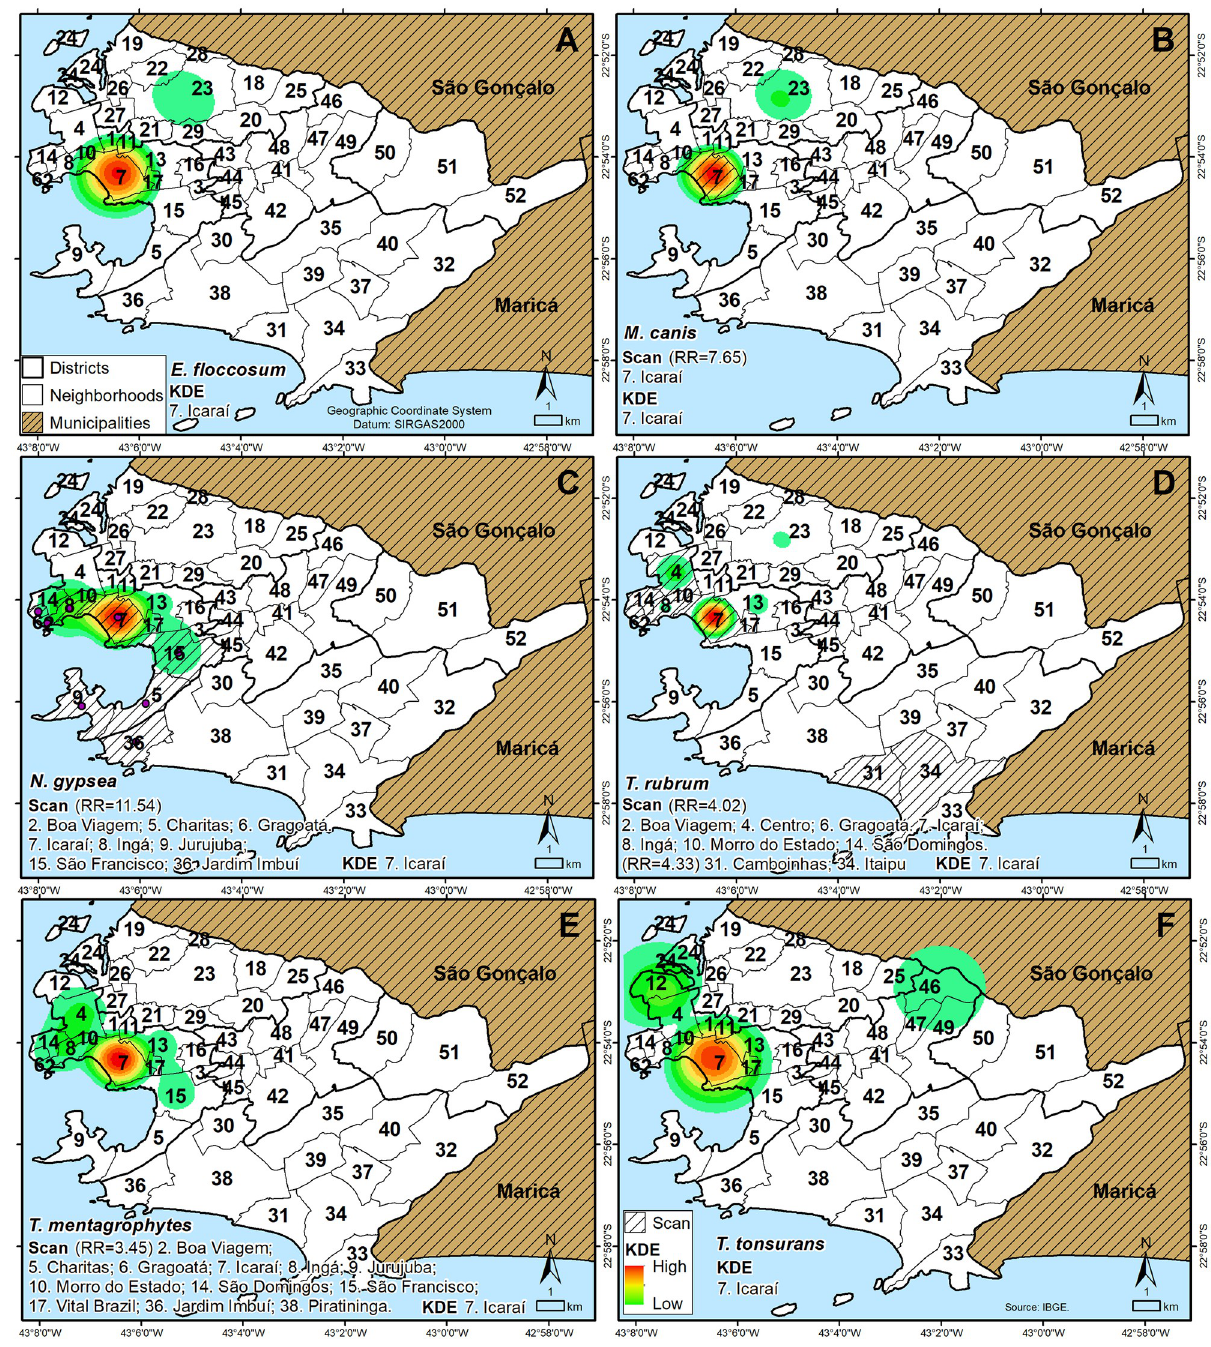
Fig 5. Application of EDK and Scan in monoinfections (A) Epidermophyton floccosum , (B) Microsporum canis , (C) Nannizzia gypsea , (D) Trichophyton rubrum , (E) Trichophyton mentagrophytes and (F) Trichophyton tonsurans in Nitero´i/RJ.(https://www.ibge.gov.br/en/geosciences/ downloads-geosciences.html).